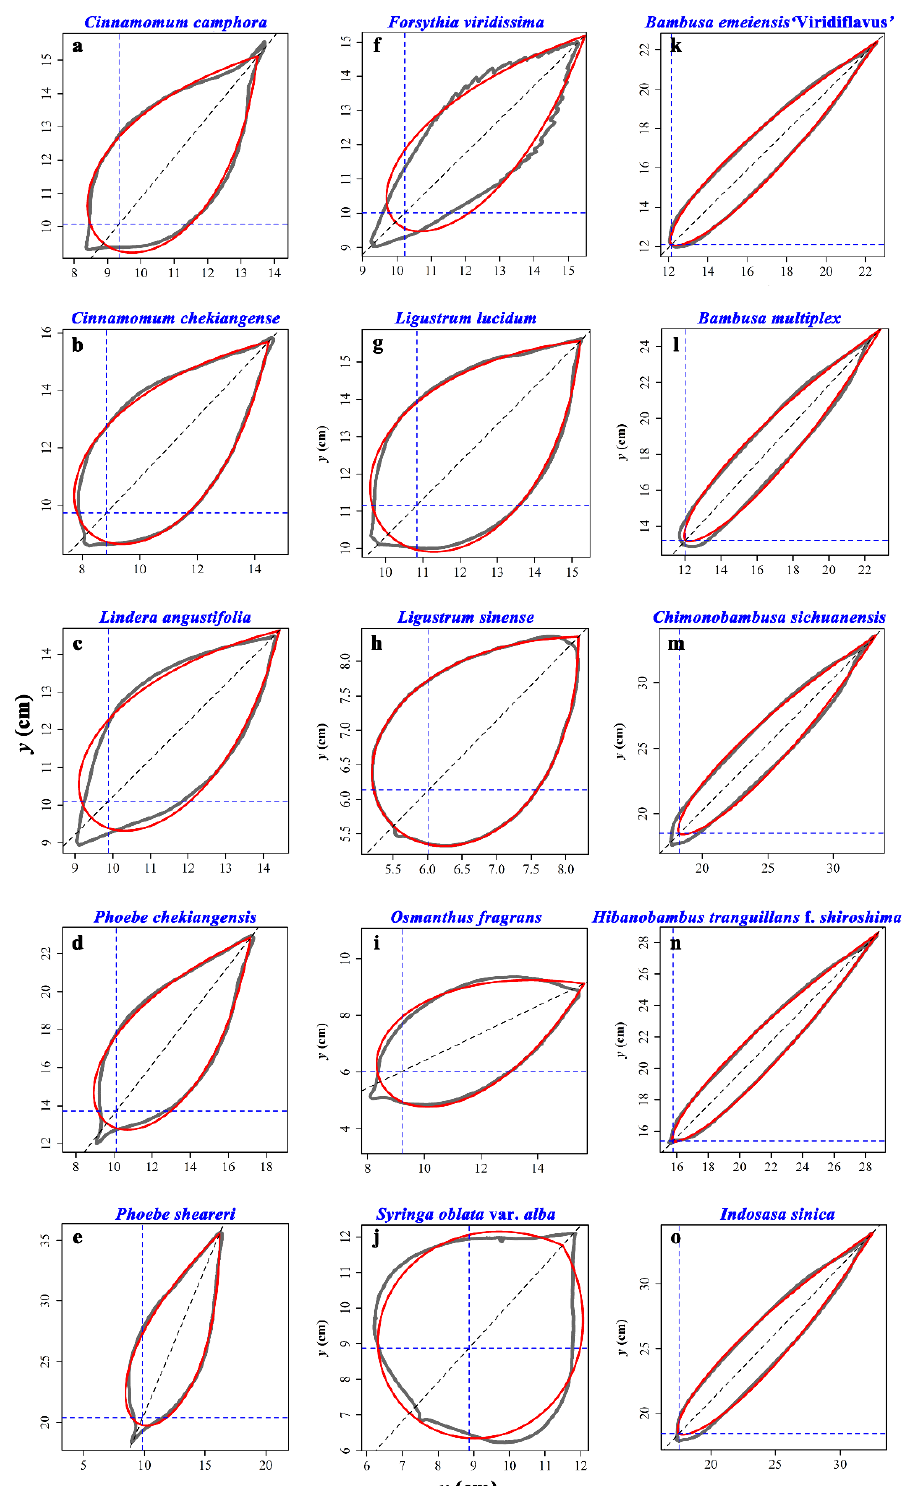
Figure 10. Gielis fit to the 15 leaf profiles: ( a ) C. camphora ; ( b ) C. chekiangense ; ( c ) L. angustifolia ; ( d ) P. chekiangensis ; ( e ) P. sheareri ; ( f ) F. viridissima ; ( g ) L. lucidum ; ( h ) L. sinense ; ( i ) O. fragrans ; ( j ) S. oblata var. alba ; ( k ) B. emeiensis ; ( l ) B. multiplex ; ( m ) C. sichuanensis ; ( n ) H. tranguillans f. shiroshima ; ( o ) I. sinica . For every panel, the gray curve represents the scanned leaf profile, and the red curve represents the leaf profile predicted by the simplified Gielis equation. The leaves correspond to those in Figure 1.